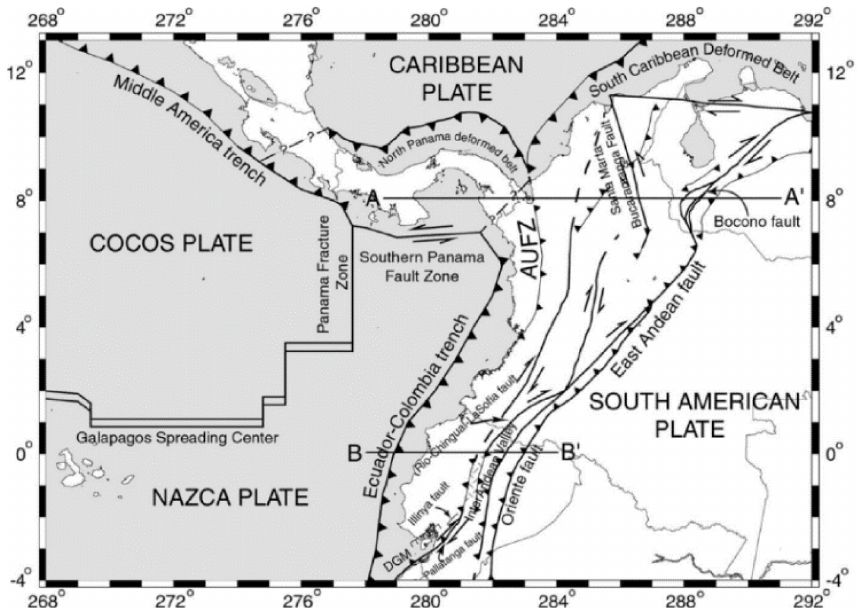
Figure 1. Plate tectonics in the northwest of South America (Trenkamp et al., 2002).